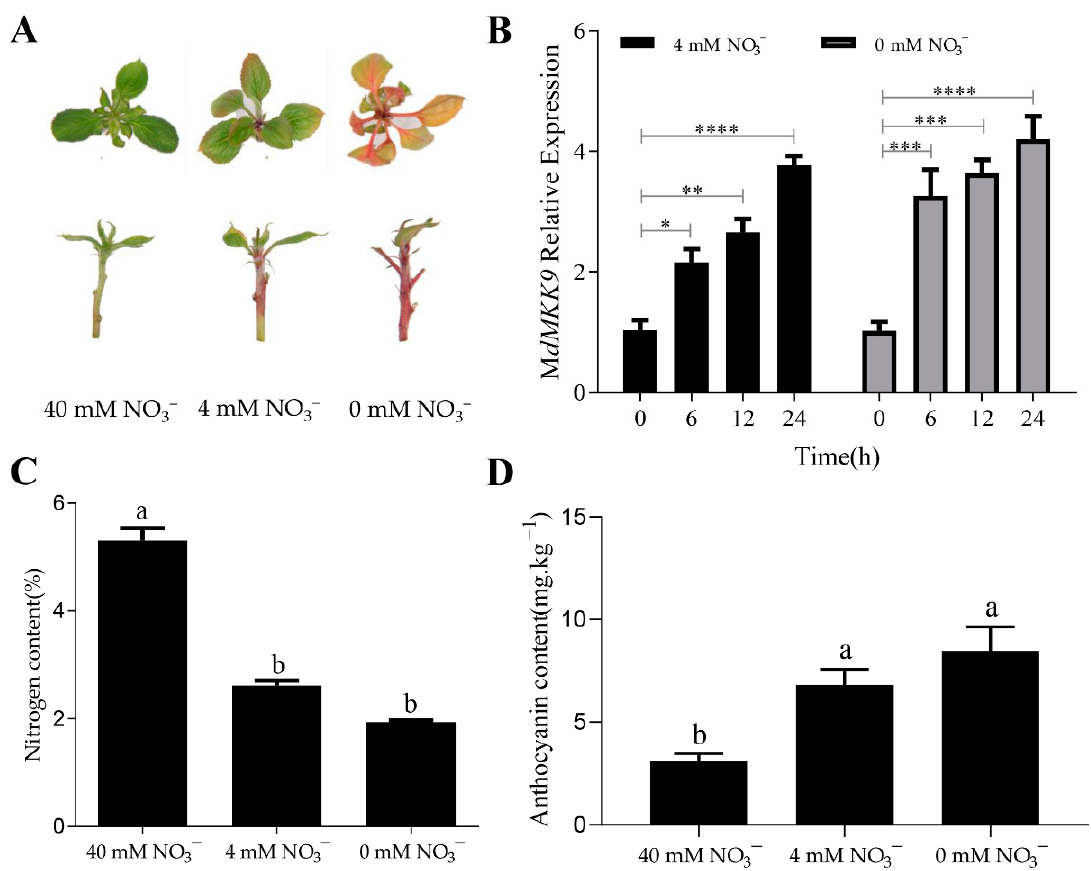
Figure 3. The phenotype, nitrogen content, anthocyanin content, and relative expression level of the MdMKK9 gene in ‘Daihong’ tissue culture seedlings grown in culture mediums with different nitrogen concentrations. ( A ) Phenotype. ( B ) Relative expression levels of MdMKK9 . The relative level of MdMKK9 in ‘Dahong’ tissue culture seedlings at 0 h was set to 1. Asterisks indicate statistically significant differences (* p < 0.05; ** p < 0.01; *** p < 0.001; **** p < 0.0001). ( C ) Nitrogen content. ( D ) Anthocyanin content. In ( C , D ), different letters above the bars indicate significant differences ( p < 0.05). The bars represent means ± SD ( n = 3).